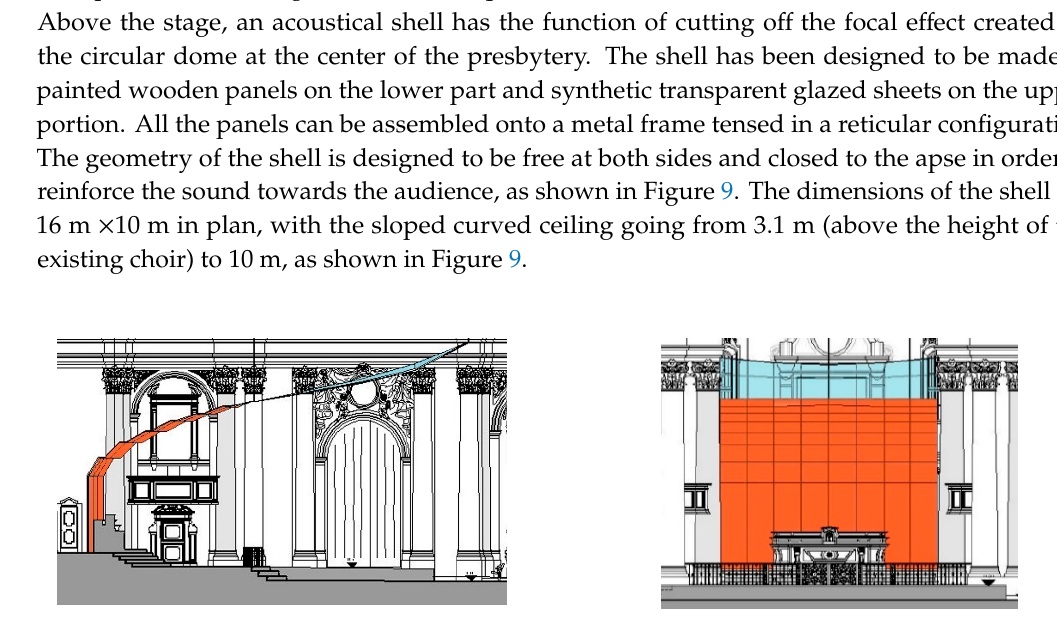
Figure 8. Existing reflectors in S. Dominic of Foligno.